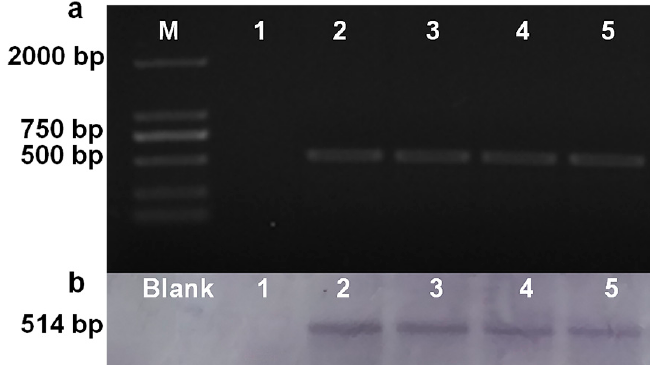
Figure 4. Southern blot hybridization analysis of strains using the region of